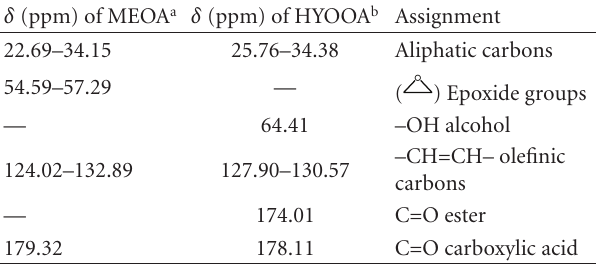
Table 6: The main signals present in 13 C NMR functional groups